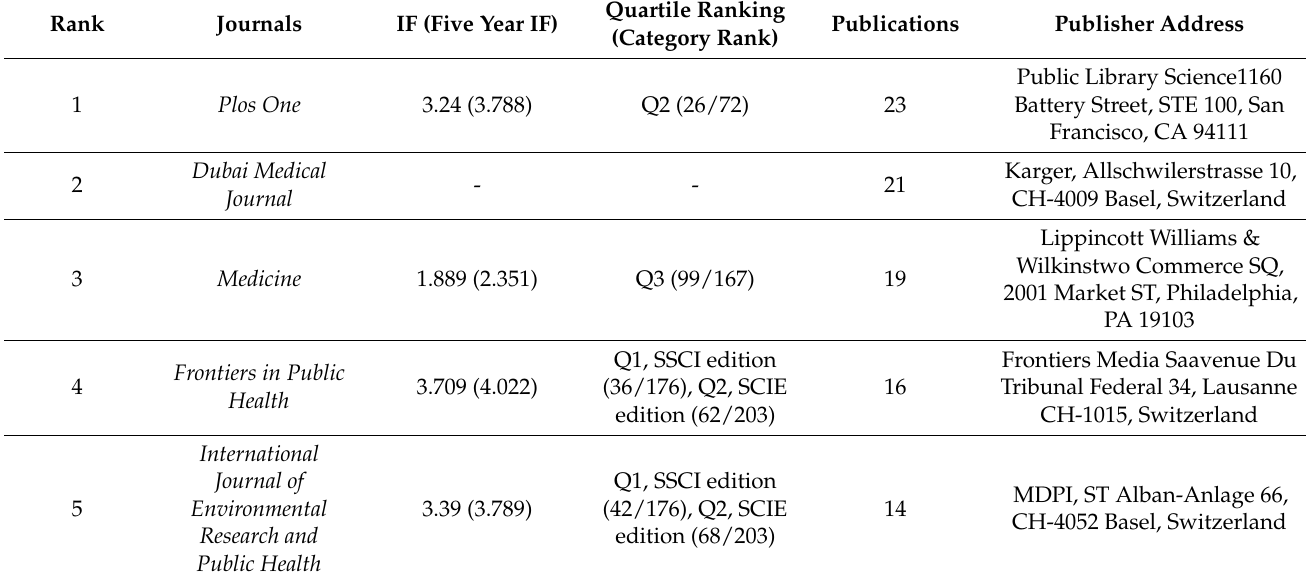
Table 3. Top five leading journals publishing the highest number of COVID-19-related